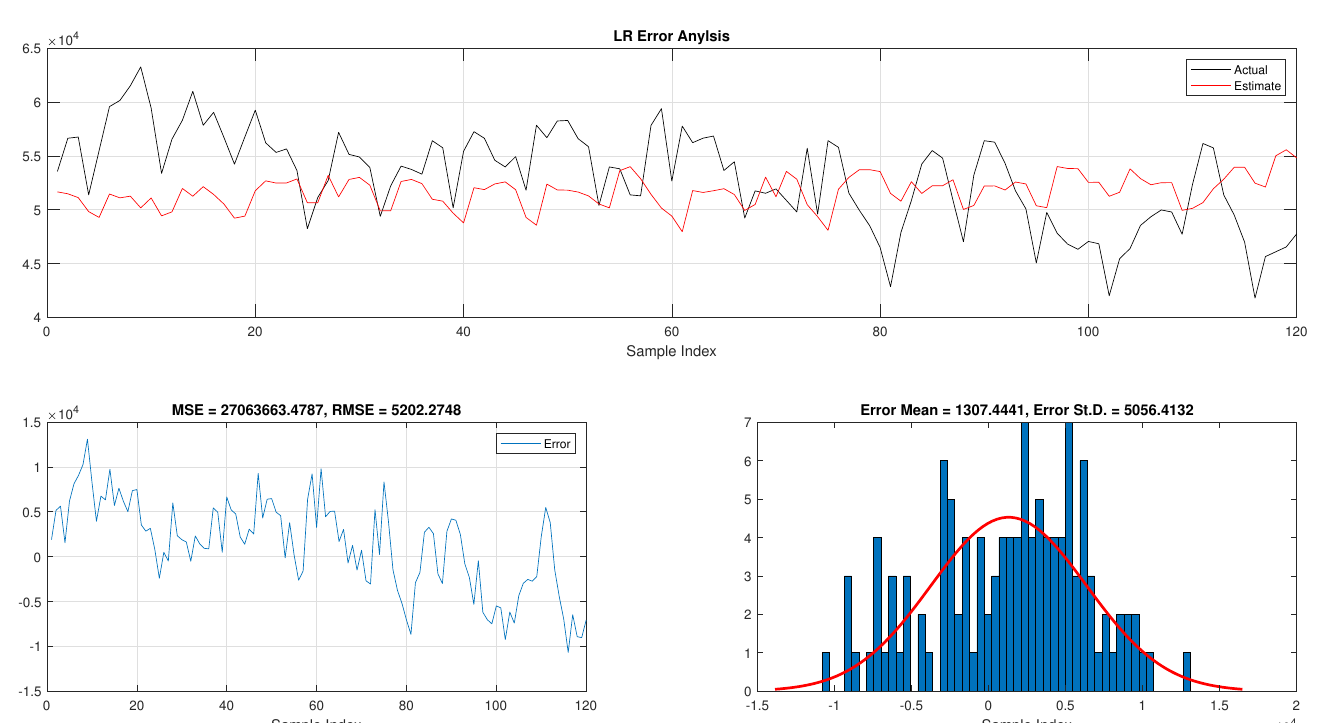
Figure 8. Error analysis of the total daily load consumption with LR best results.